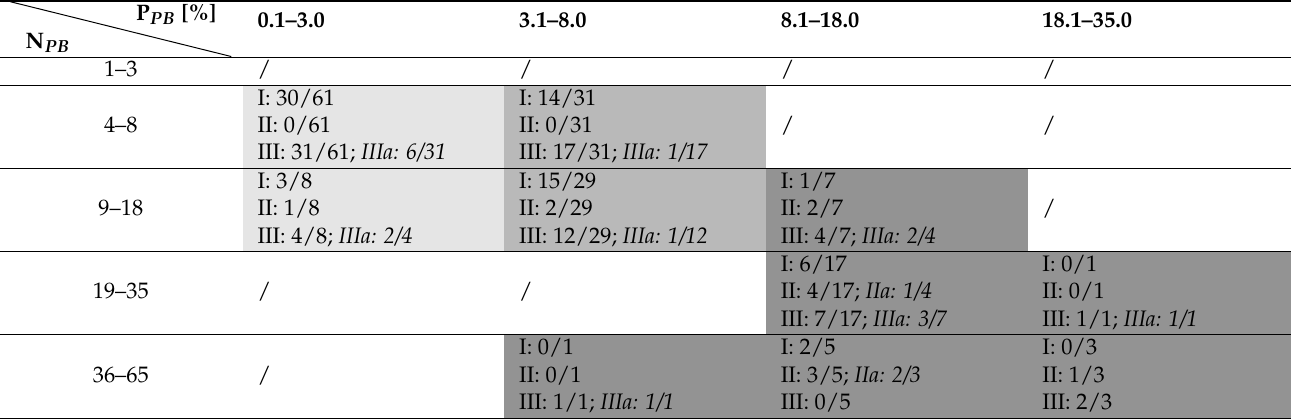
Table 4. Number of 100 × 100 m grid cells that: contain sufficient parking capacity (I); are partially covered with parking capacity (II); are partially covered with parking capacity but some cells have close access to the neighboring cell’s parking capacity (IIa); contain no parking capacity (III); or contain no parking capacity but some cells have close access to the neighboring cell’s parking capacity (IIIa). Shades of gray additionally show relevances assigned in Table 2. N PB